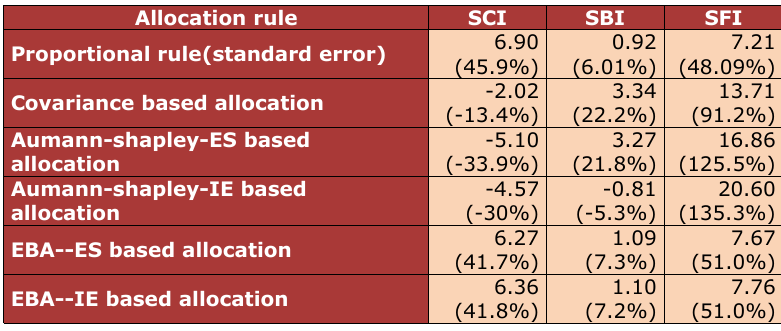
Table 2. Risk capital allocation under different